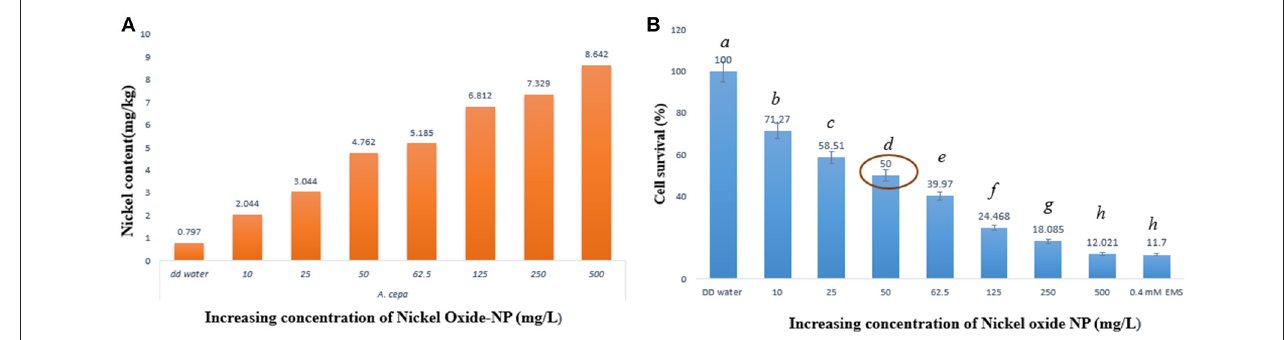
FIGURE 3 | Aberrations induced by NiO-NP suspension in various species of Allium as observed under Optical, Flourescene and Confocal microscopes: (A) telophase bridge in A. sativum , (B) nucleus breakage in A. schoenoprasum , (C) laggards in A. porrum, (D) vagrants after duplication in A. cepa , (E) nucleus damage in A. cepa , (F) chromosome breakage in A. porrum, (G) C-mitosis in A. fistulosum , (H) binucleate cell in A. sativum , (I) double anaphase bridge in A. cepa, (J) micronucleus in A. cepa, (K) laggard and vagrant chromosomes in A. fistulosum , (L) anaphase bridge with laggard and early migration in A. porrum (bar = 10 µ m).